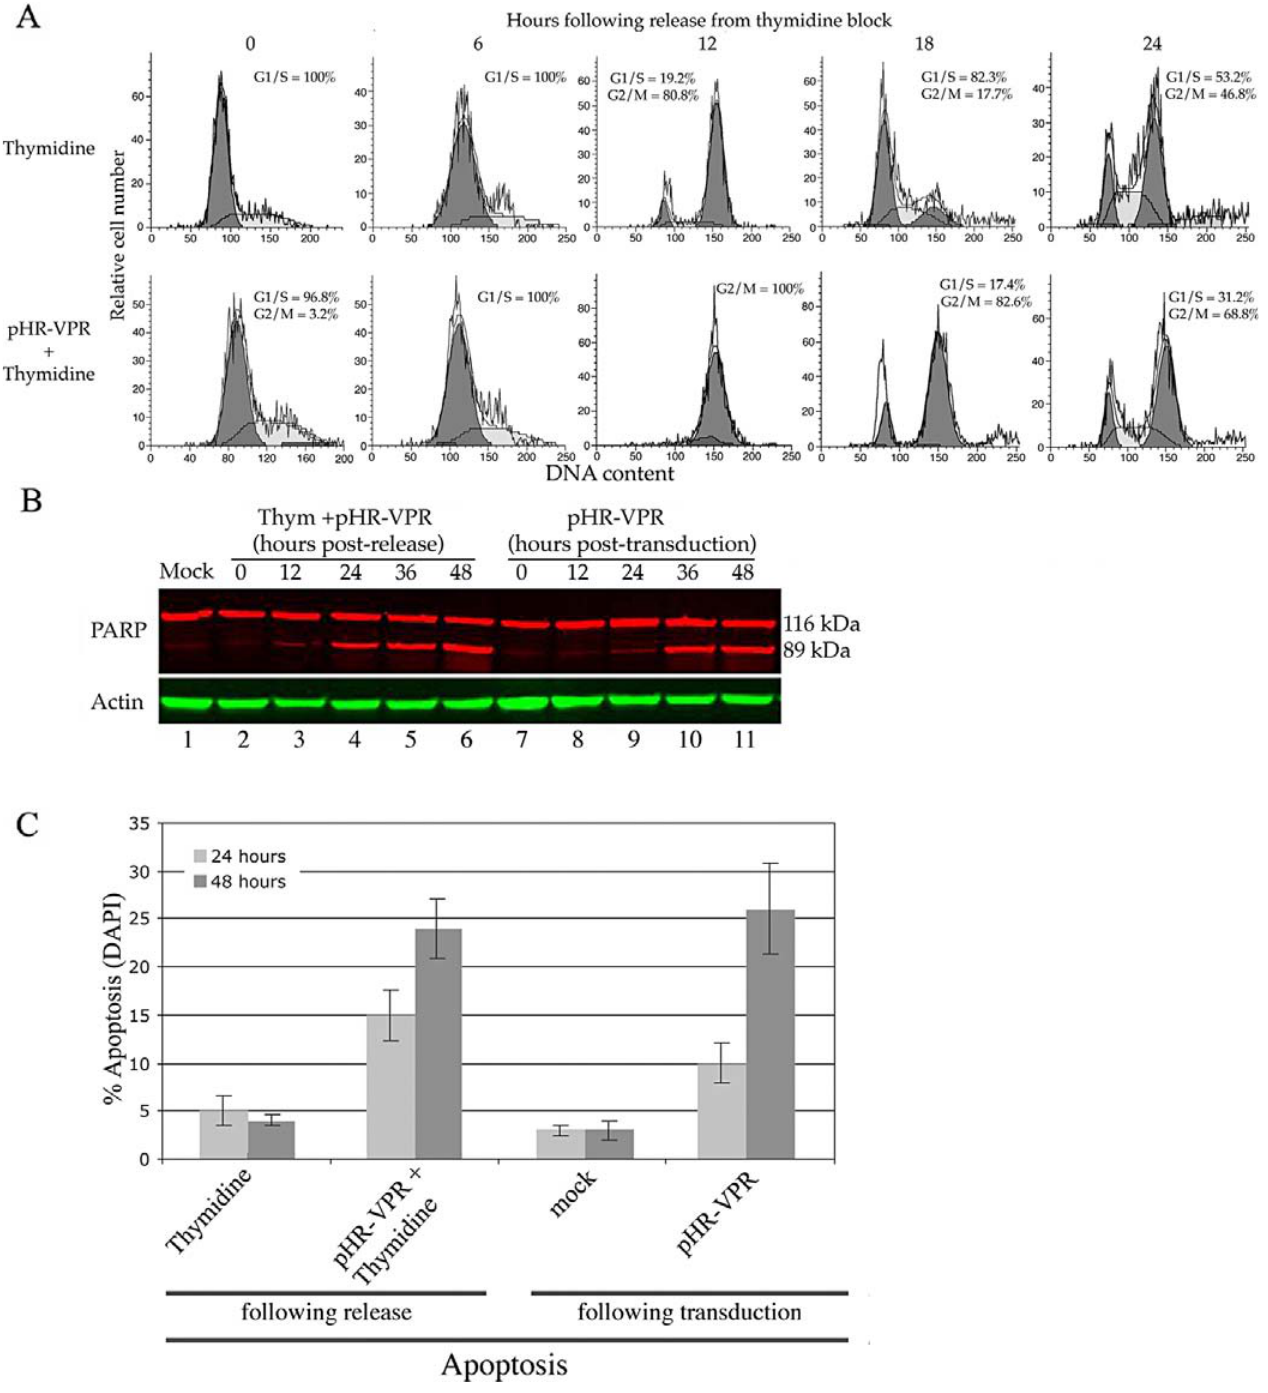
Figure 3. Release of Vpr-Expressing Cells from Thymidine Block Leads to Reentry into the Cell Cycle and Vpr-Induced, G 2 -Dependent Apoptosis (A) Thymidine-synchronized HeLa cells transduced with pHR-VPR-G or mock-transduced were released from thymidine block and harvested at specified time points postrelease. Cells from each time point were stained with PI and analyzed for DNA content by flow cytometry. (B) pHR-VPR–transduced HeLa cells from the same experiment were monitored by Western blot for PARP cleavage at specified time points. Time points labeled under ‘‘ Thym þ pHR-VPR ’’ indicate hours following release from thymidine block; time points under ‘‘ pHR-VPR ’’ indicate hours following transduction, as these cells were not synchronized. (C) Cells treated as those in (A) and (B) were harvested at 24 and 48 h were analyzed for apoptosis by DAPI staining, and the results are